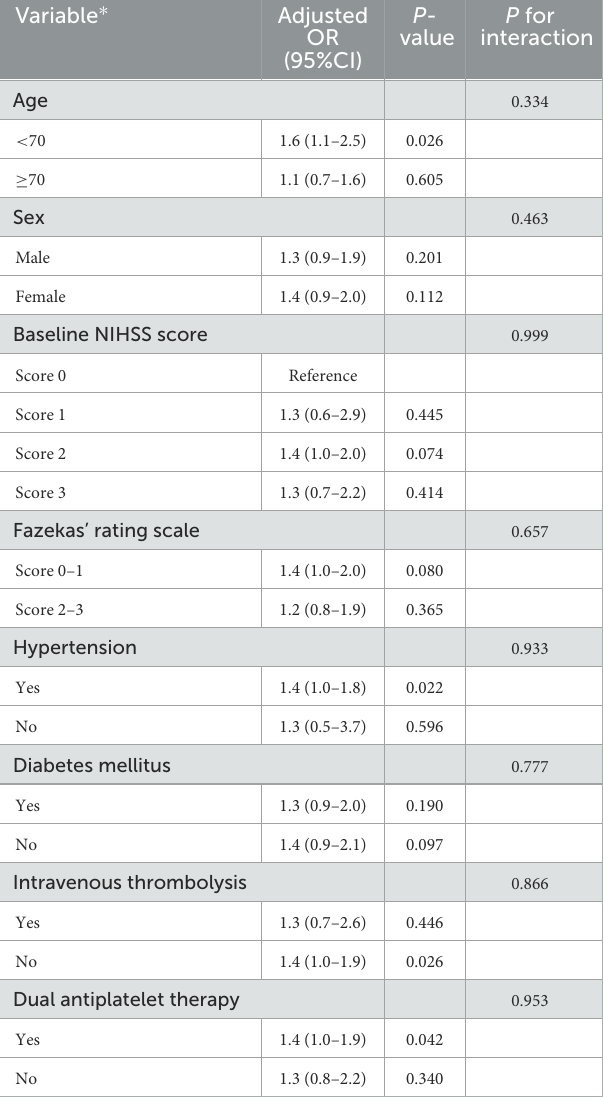
TABLE 4 Stratified logistic regression analyses to identify variables that might modify the association between sNfL and END in patients with